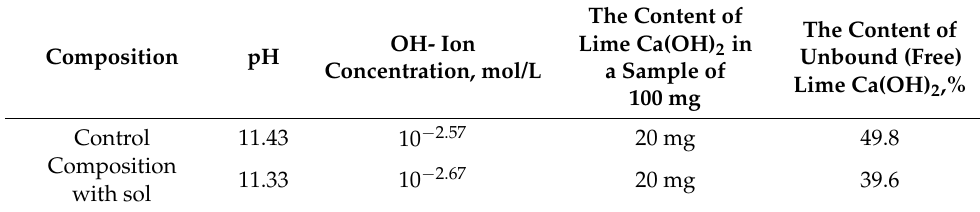
Table 7. Results of determining the amount of free